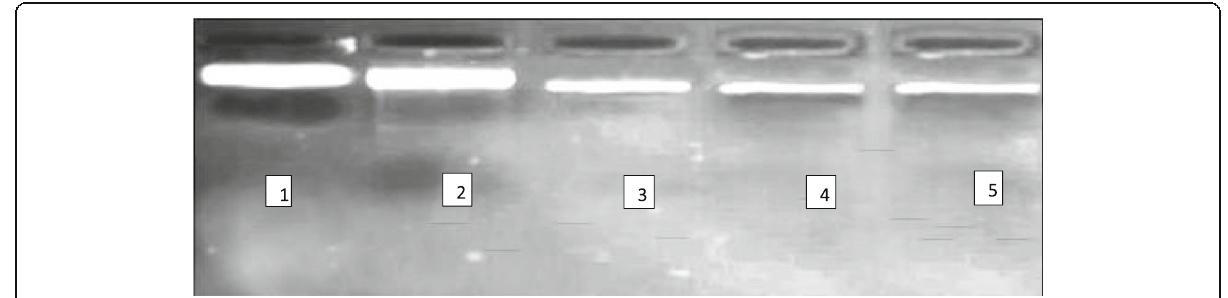
Fig. 14 Gel image showing DNA of the